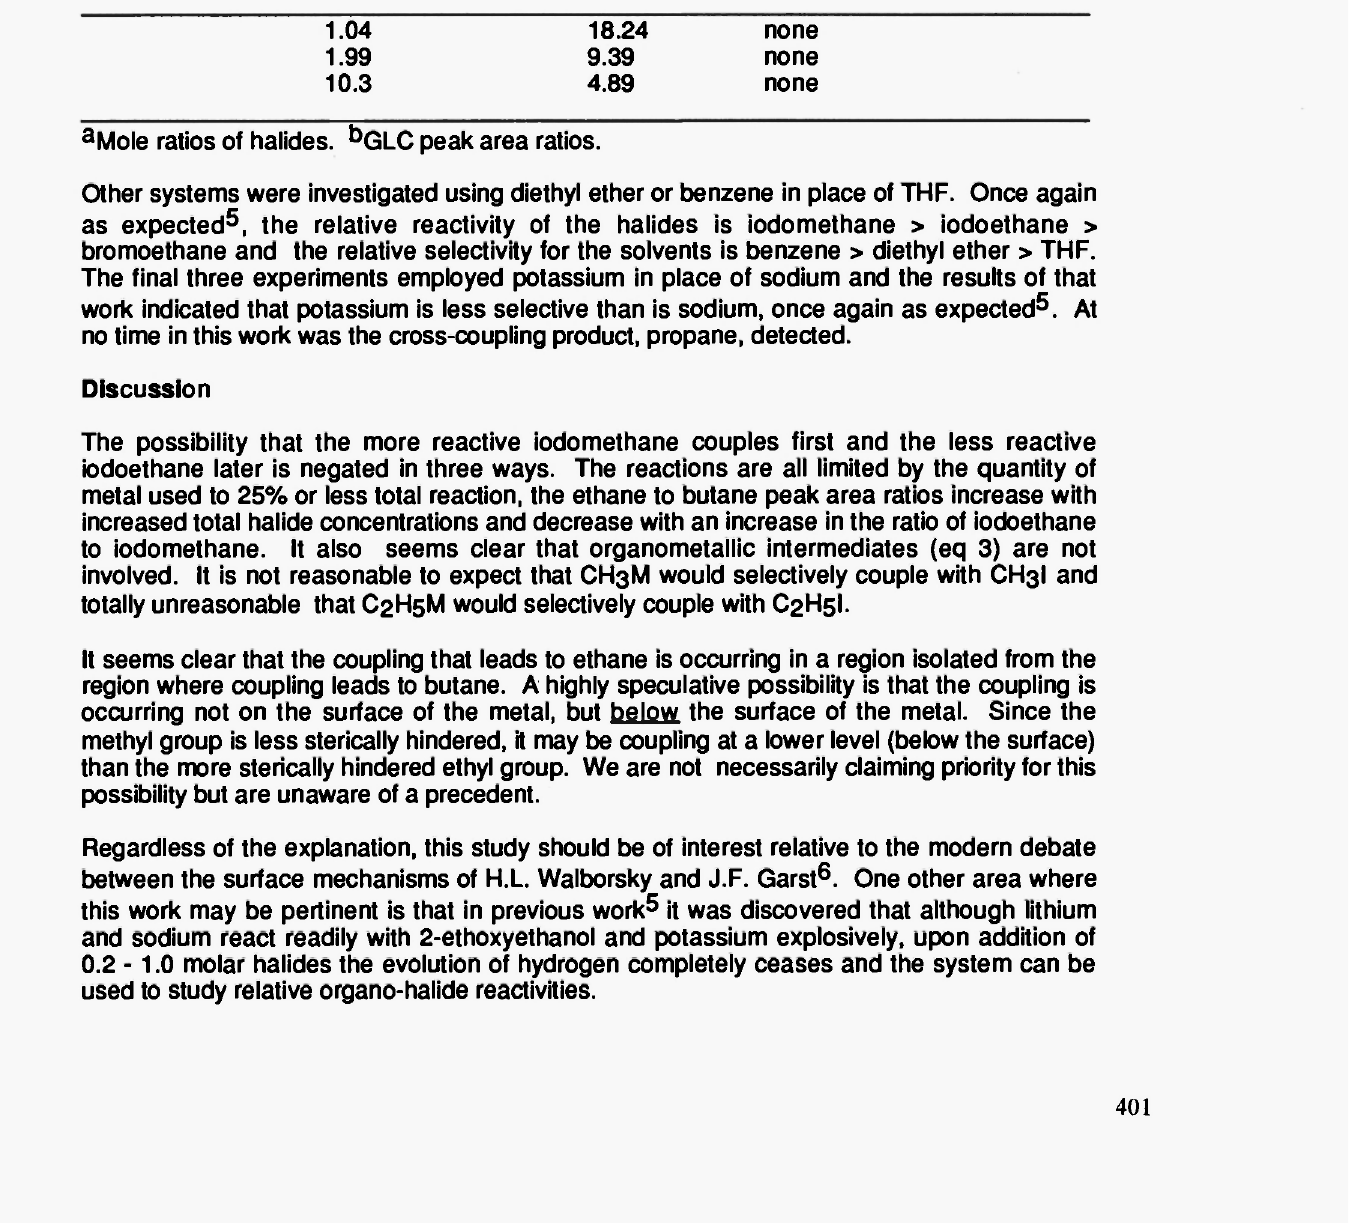
Table IV. Results from increasing the molar ratios of bromoethane to iodomethane in a 1.04 Μ total halide solution in THF at room temperature, over